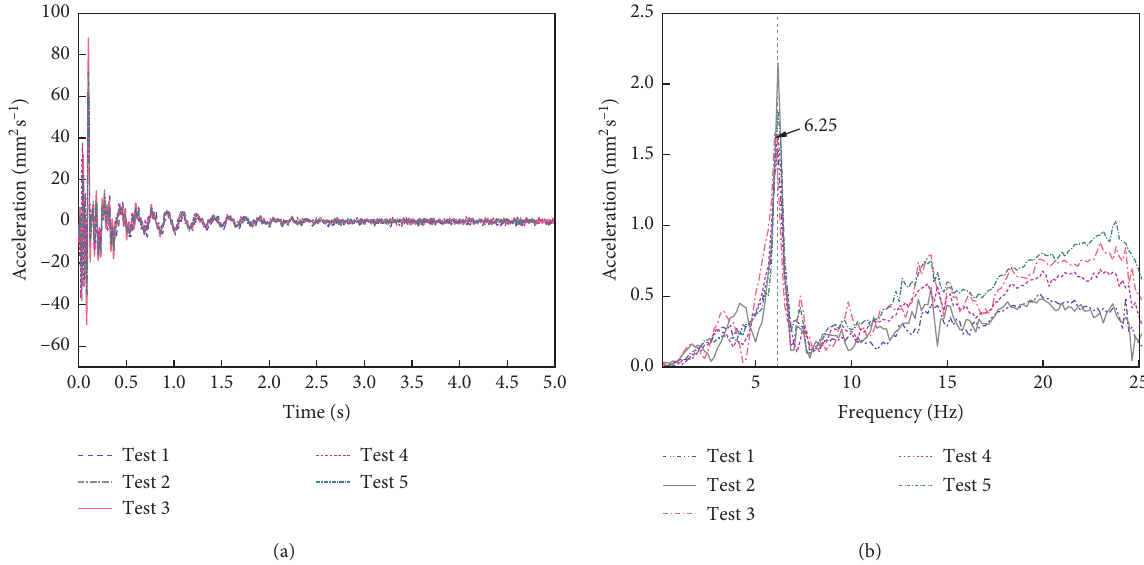
Figure 9: Typical time-domain curve and frequency-domain curve induced by single-person jumping tests: (a) acceleration responses; (b) corresponding frequency responses.